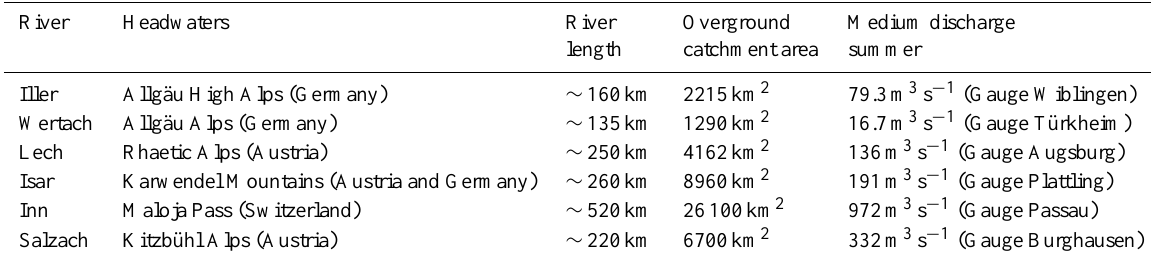
Table 1. Reference data of the Bavarian Foreland rivers, modified after different authors. The information under “Medium discharge summer” refers to the lowest official downstream gauge.